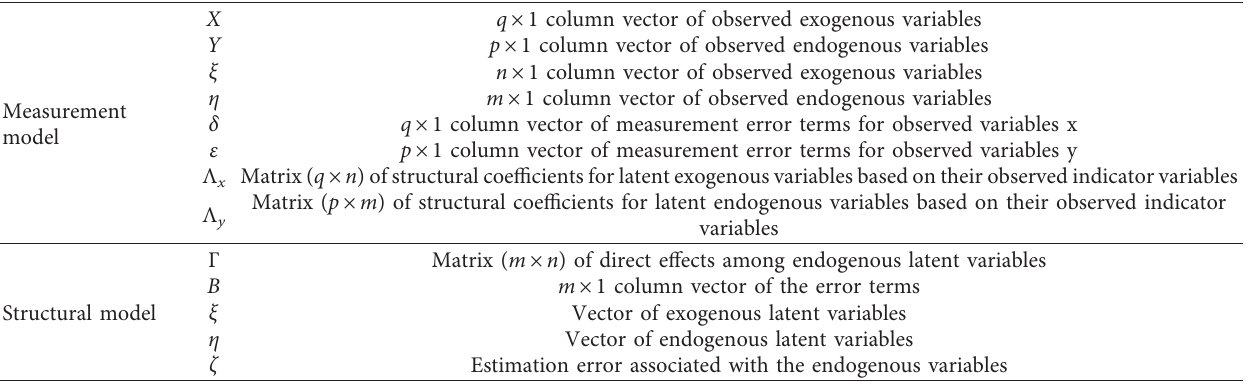
Table 3: Definitions of SEM elements